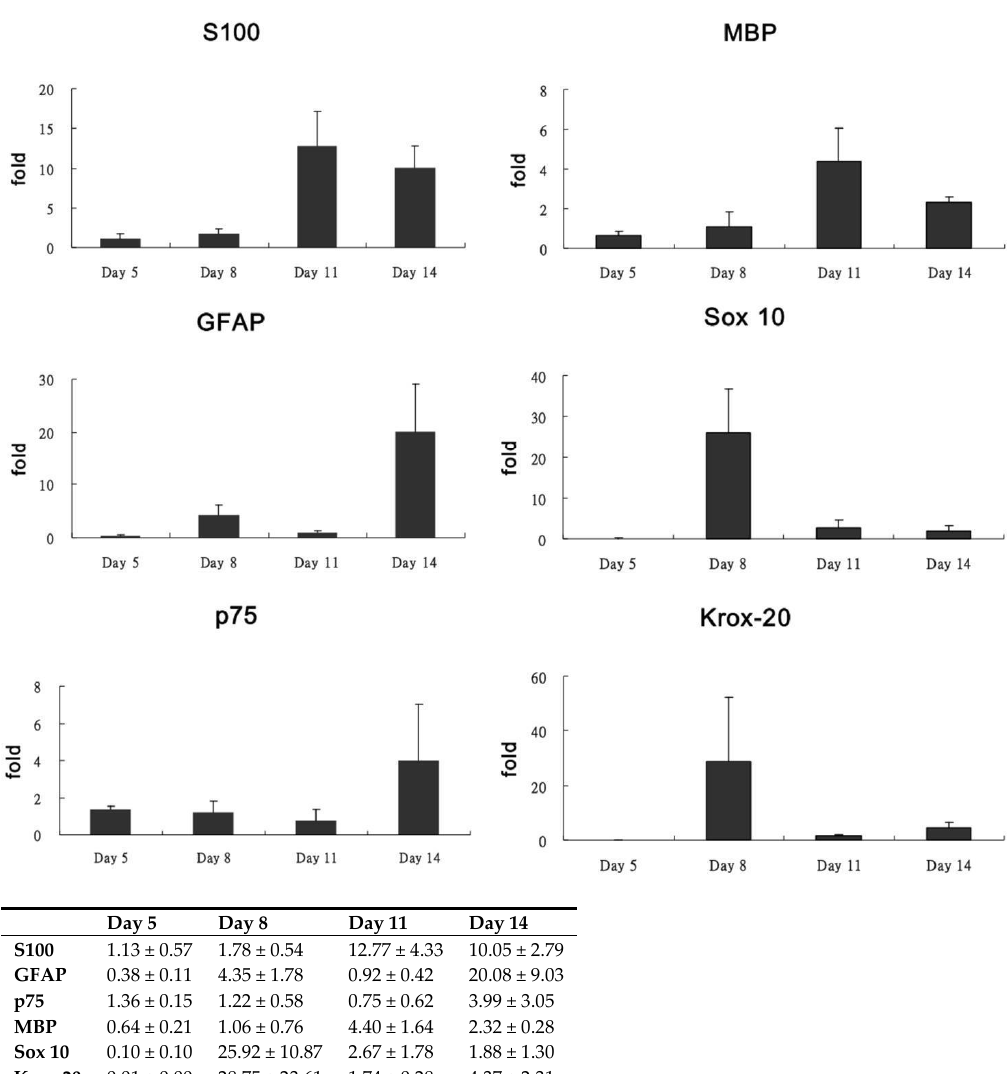
Figure 5. Ratio of mRNA expression of various genes to that of GAPDH (Glyceraldehyde 3-phosphate dehydrogenase) on days 5, 8, 11, and 14. Expression of S100 and MBP (myelin basic protein) was observed markedly on days 11 and 14. The highest expression of GFAP (Glial fibrillary acidic protein) and p75 was observed on day 14. Comparatively, the early developmental markers of Schwann cells, Sox 10 and Krox-20, were most noticeable on day